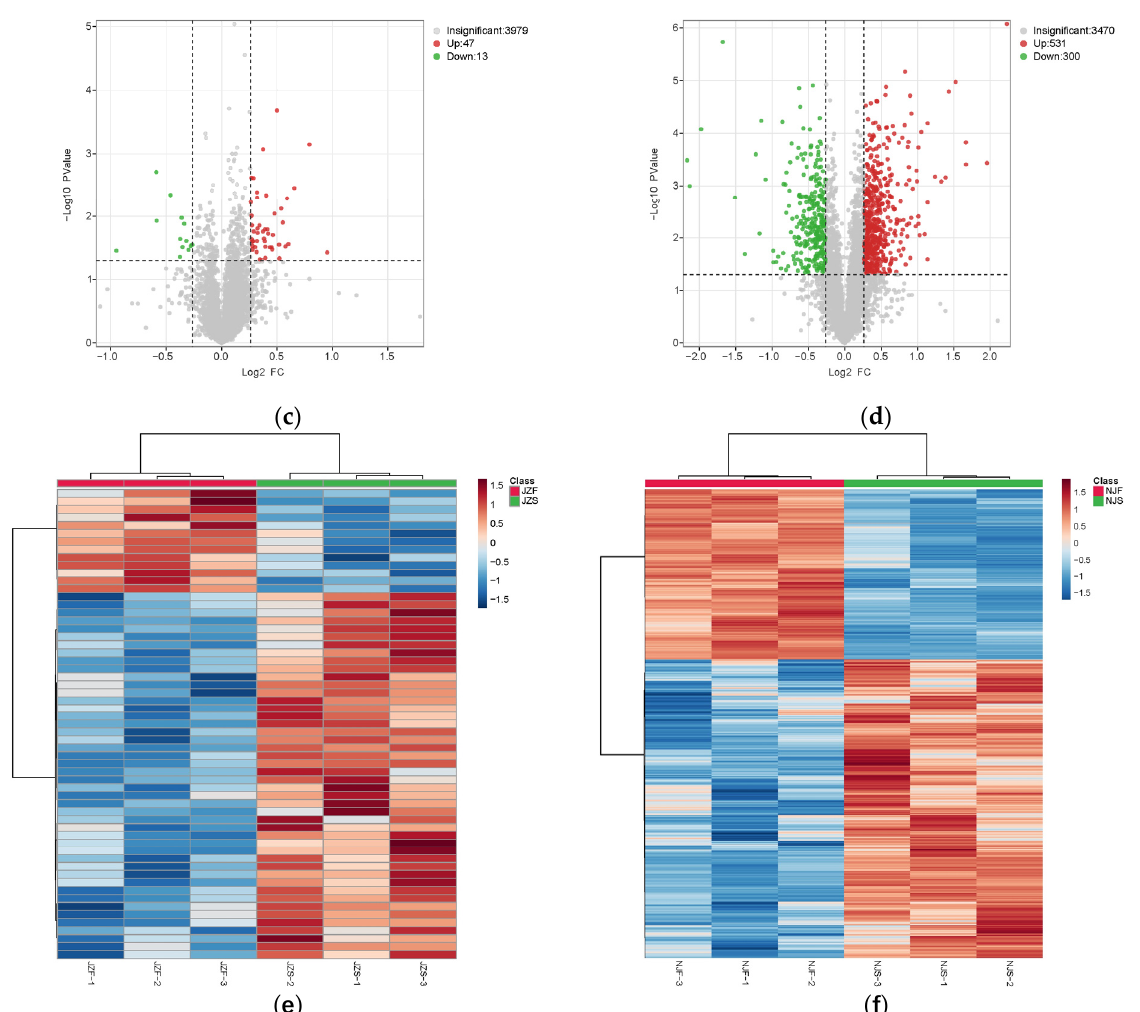
Figure 3. Protein variation across stored rice compared with fresh rice. ( a ) PLS-DA score plot of JZ. ( b ) PLS-DA score plot of NJ. ( c ) Volcano plot of DEPs in JZ. ( d ) Volcano plot of DEPs in NJ. ( e ) Heatmap for DEPs in JZ. ( f ) Heatmap for DEPs in NJ.